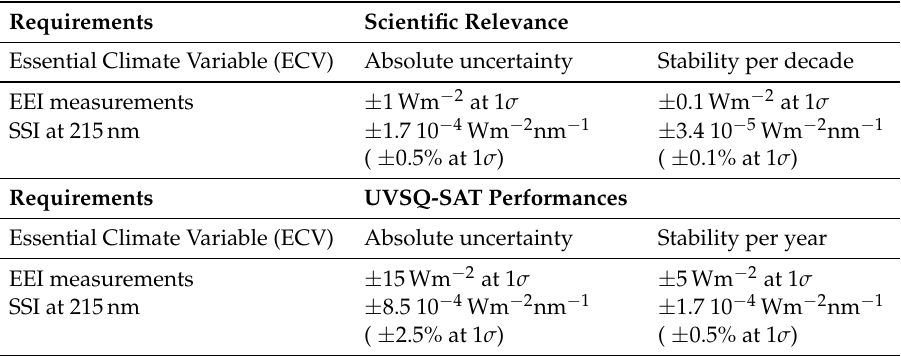
Table 1. Scientific requirements for Earth’s energy imbalance and solar spectral irradiance in the Herzberg continuum (high scientific relevance and UltraViolet and infrared Sensors at high Quantum efficiency onboard a small SATellite (UVSQ-SAT) expected performances). EEI, Earth’s Energy